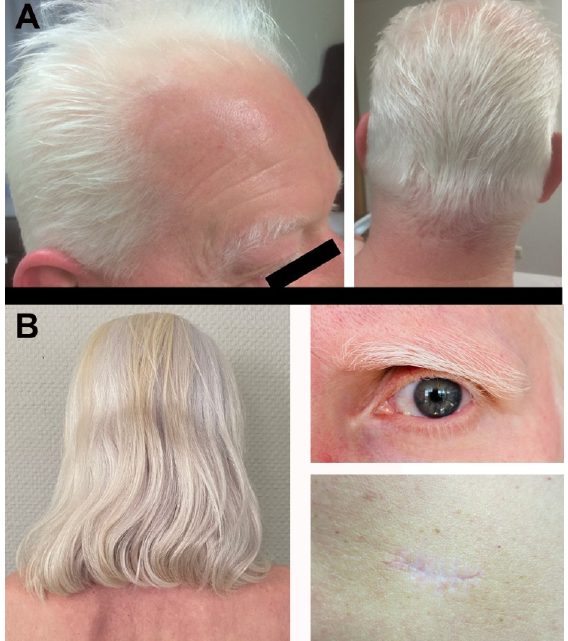
Figure 4. Clinical presentation of poliosis after complete response to combined immunotherapy in a male patient ( A ) with initial melanoma metastatic to the skin, lung, liver, brain, peritoneum, right heart atrium, lymph nodes, adrenal gland and bones and a female patient ( B ) with clinical presen- tation of poliosis to the hair, eyelids and scars after complete response to initially multifocal meta- static melanoma showing cerebral, bipulmonal, gastric, pancreatic, renal and intestinal metastasis.